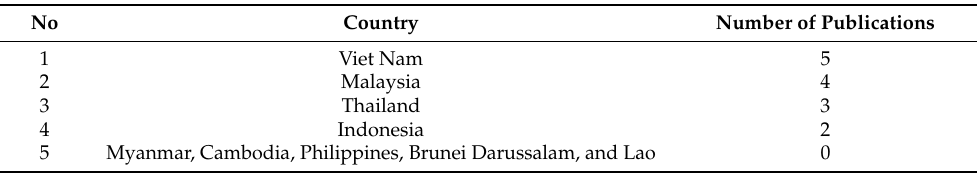
Table 2. Number of publications from each country.